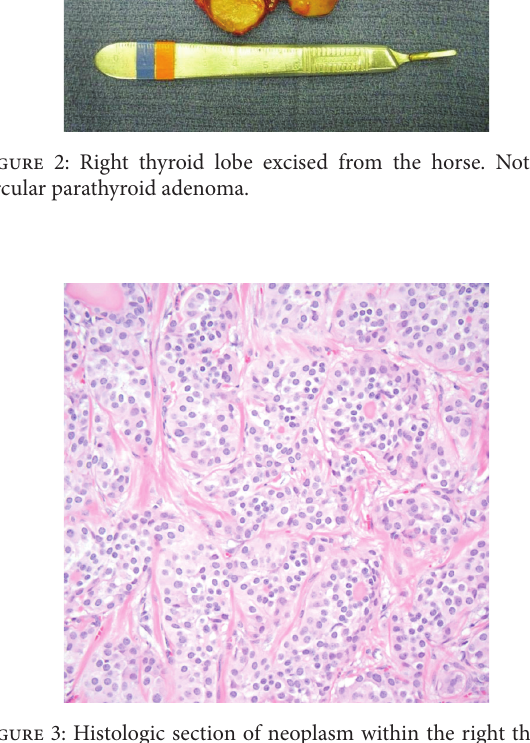
Figure 3: Histologic section of neoplasm within the right thyroid lobe excised from the horse. Hematoxylin and eosin, 20x.